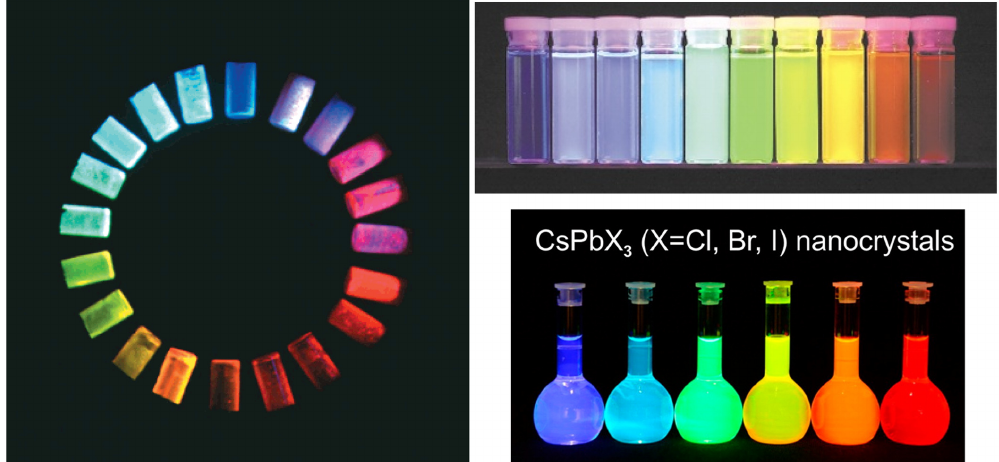
Figure 1. ( left ) Photoluminescence color tunability obtained by functionalized dioxide-oligothiophenes with different conjugation length. Reprinted with permission from [1]. American Chemical Society, 2000. ( top right ) Photoluminescence color tunability in II–VI quantum dots with different sizes. Adapted with permission from [31]. Springer Nature Publishing, 2001. ( bottom right ) Full emission color tunability of fully inorganic CsPbX 3 NCs with different chemical composition. Reproduced with permission from [32]. American Chemical Society,